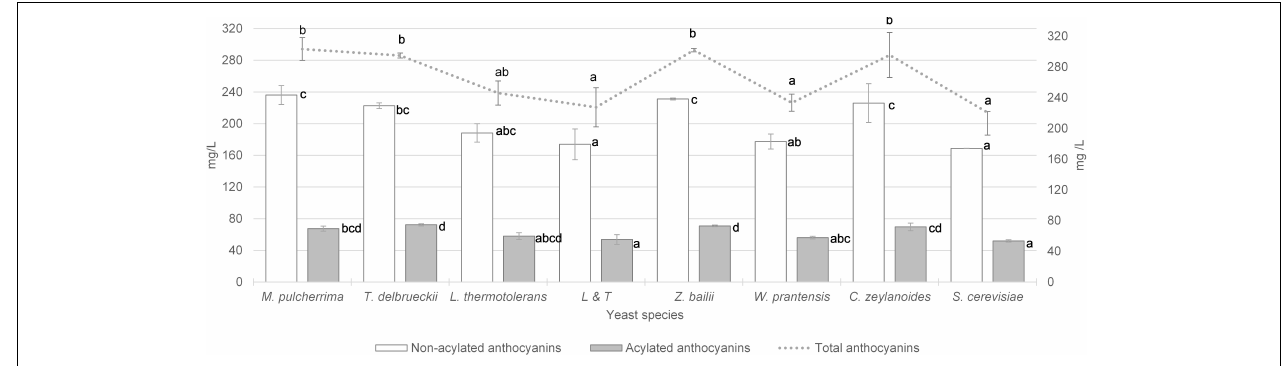
FIGURE 1 | Total anthocyanins content (mg/L) and content of non-acetylated and acetylated anthocyanins in wine vinified with different yeasts species. Error bars represent the standard deviation ( n = 2). Different letters mean significant differences between the samples ( p ≤ 0.01). No letters mean no significant differences.